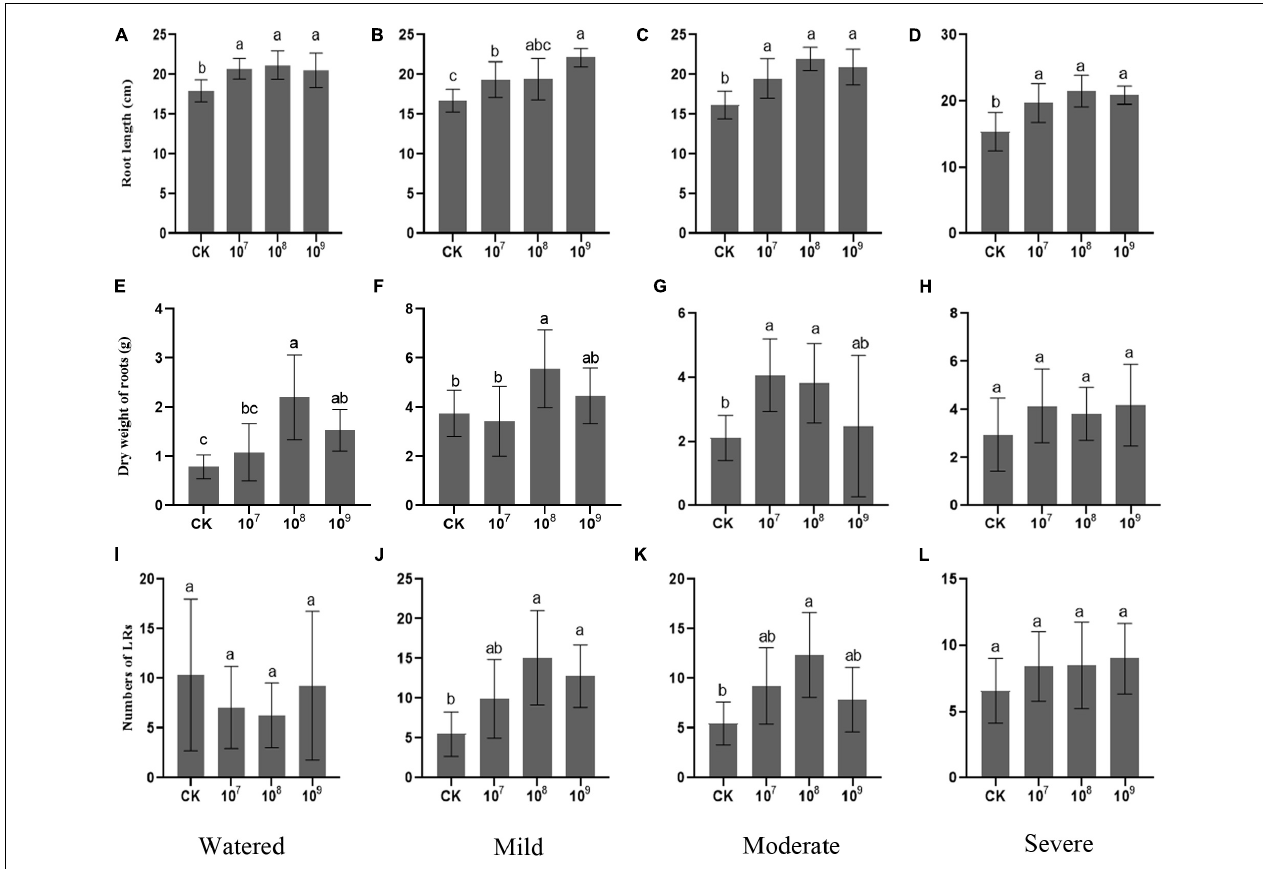
FIGURE 1 | Bacillus amyloliquefaciens FZB42 improves the root growth of Glycyrrhiza uralensis under drought. The far-left column is the control group (watered condition) followed to the right by increasing drought stress conditions (mild, moderate, severe). The panel rows show growth responses in terms of (A–D) root length ( F -value = 8.1, 9.6, 15.5, 11.5), (E–H) dry weight of roots ( F -value = 13.8, 8.0, 5.9, 1.4), and (I–L) counts of lateral roots (LRs) ( F -value = 1.1, 8.3, 7.4, 1.4). Bars are the mean ± SE ( n = 15). CK, zero